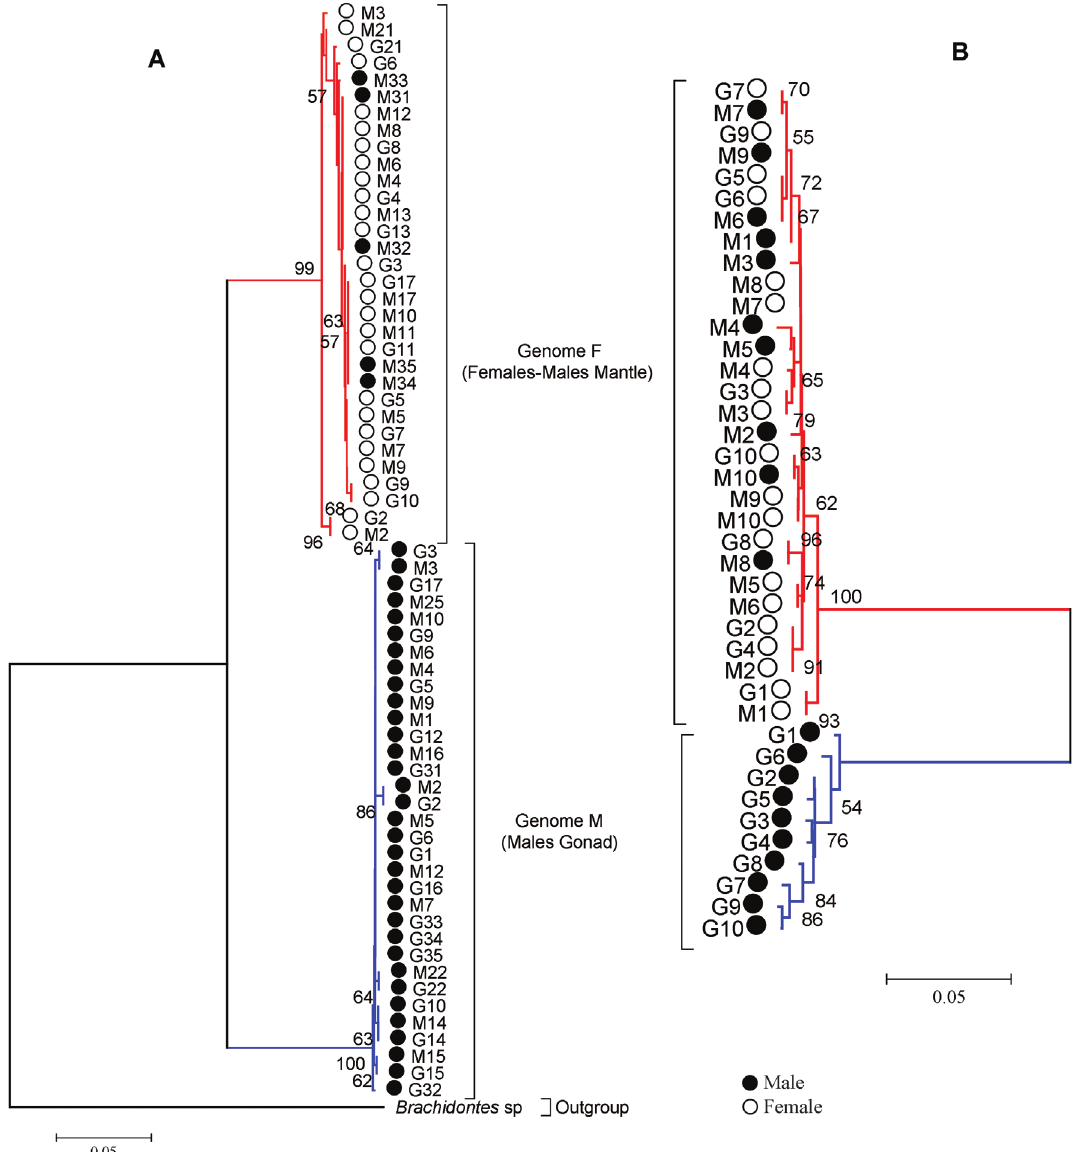
Figure 3 - Neighbour-joining tree of mitochondrial haplotypes in P. purpuratus , based on (A) the mitochondrial gene 16S and (B) COI gene . M: mantle tissue; G: gonadal